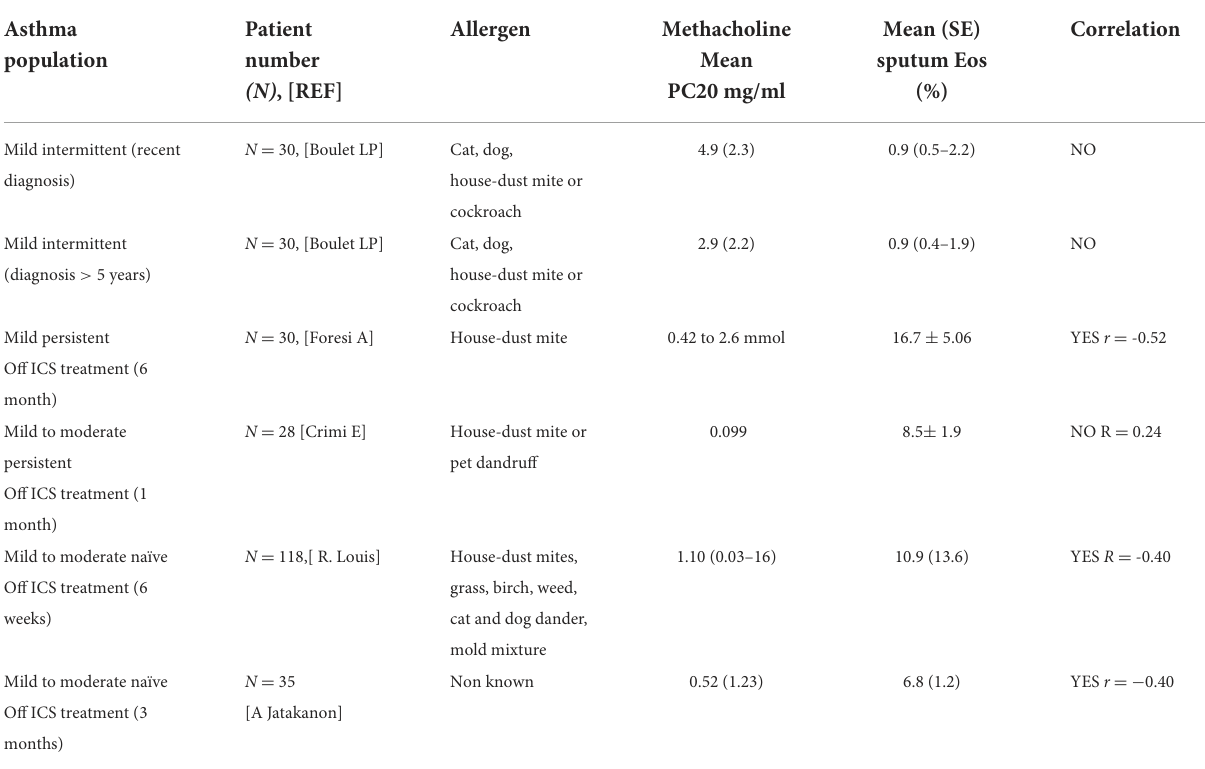
TABLE 4 Relationship between sputum eosinophils and AHR in asthmatic